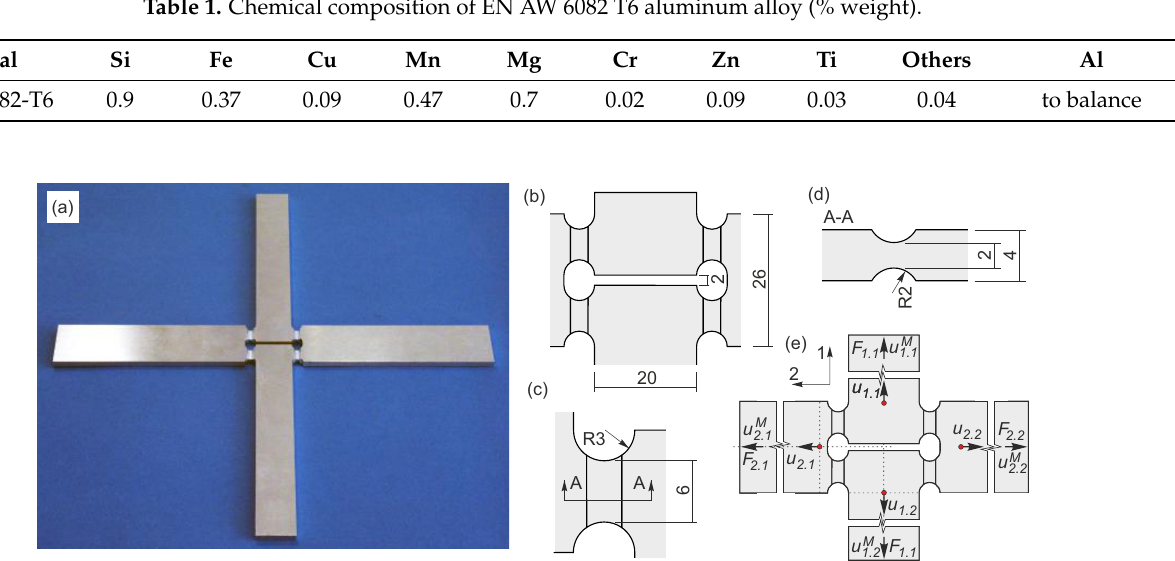
Figure 2. Geometry ( a – d ), loading, and displacements ( e ) of the H-specimen (all dimensions in